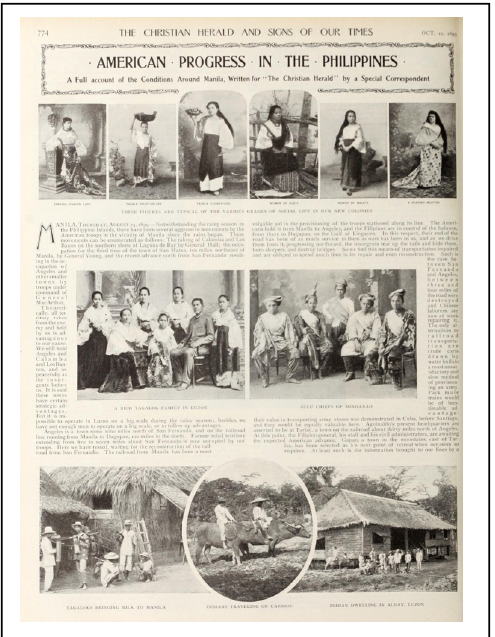
Figure 4. Grades of Social Life in the Philippines. Christian Herald , 11 October 1899, p. 774.